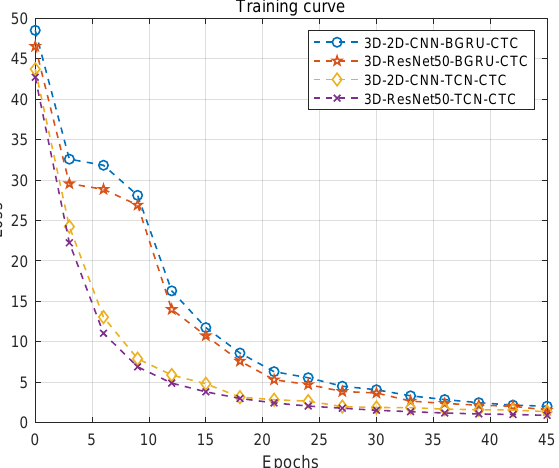
Figure 7. Training curve. Training Loss curves with epochs for four different architectures. Epoch and Loss in the figure, respectively, represent the number of Epoch and the Loss reached under the Epoch.